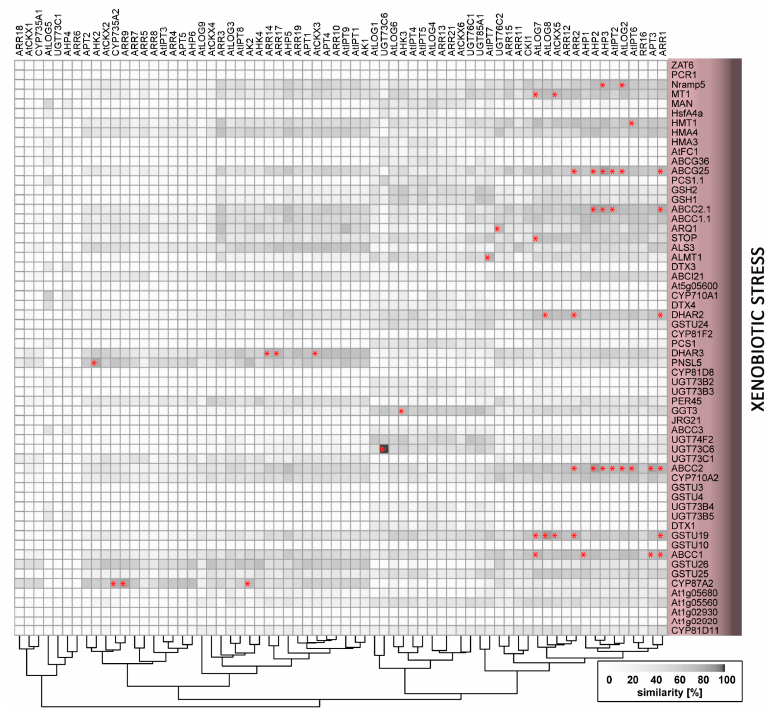
Figure 3. Similarity of expression patterns of genes related to xenobiotic stress and genes involved in cytokinin metabolism or signalling. Asterisks indicate profile similarities >85%. The heatmap was generated using R software and available data from Araport [33].